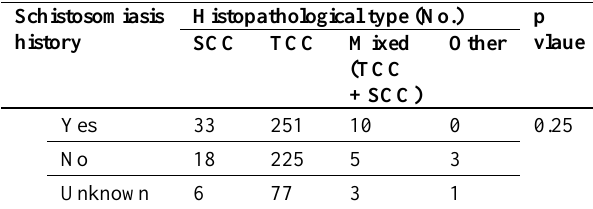
Table 3: Distribution of schistosomiasis history among different histopathological types Schistosomiasis